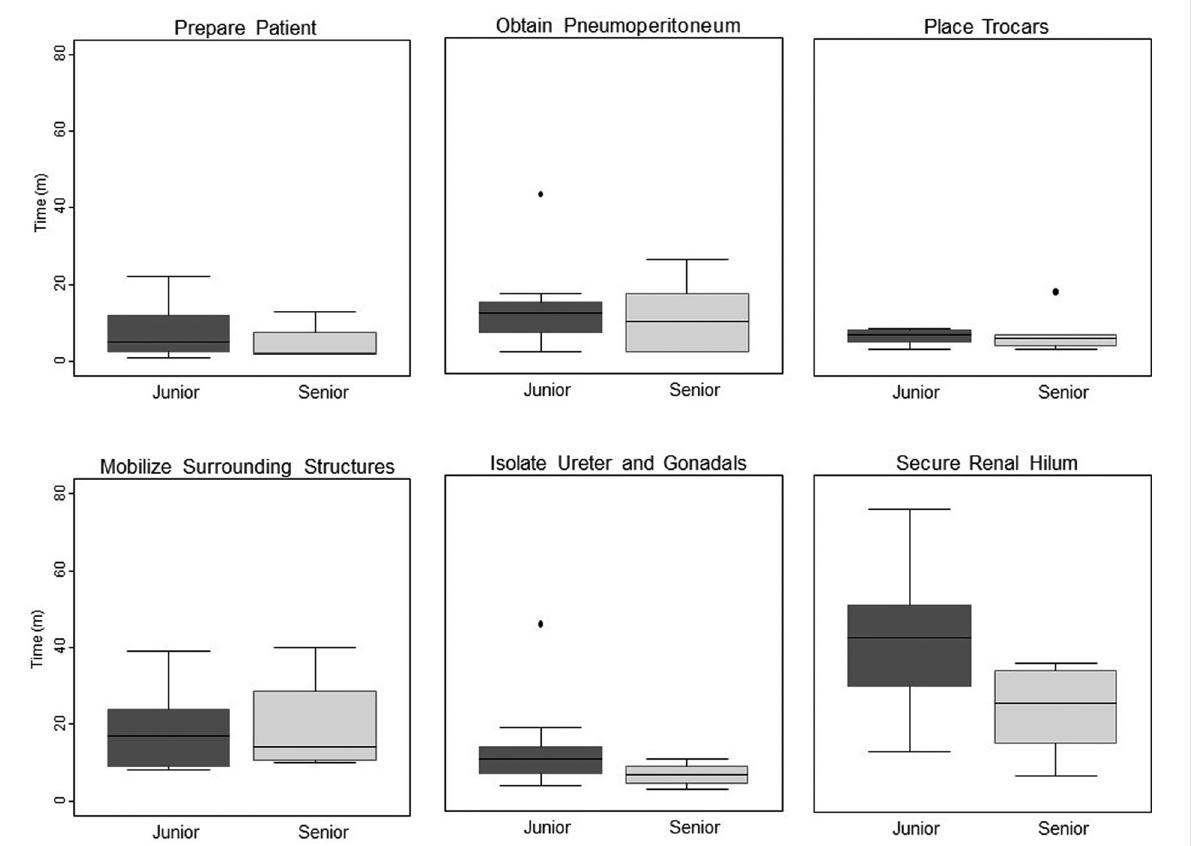
FIGURE 1 Time differential between junior vs. senior residents completing key steps in simulated laparoscopic radical and partial